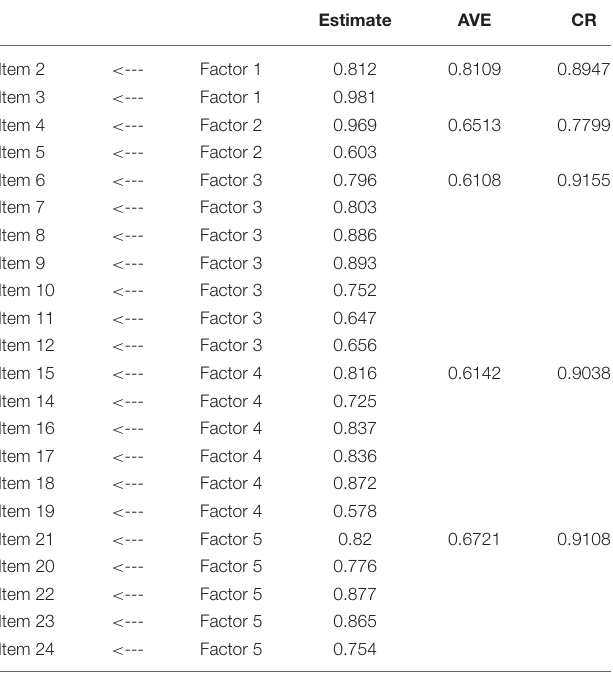
TABLE 6 | Convergent validity.